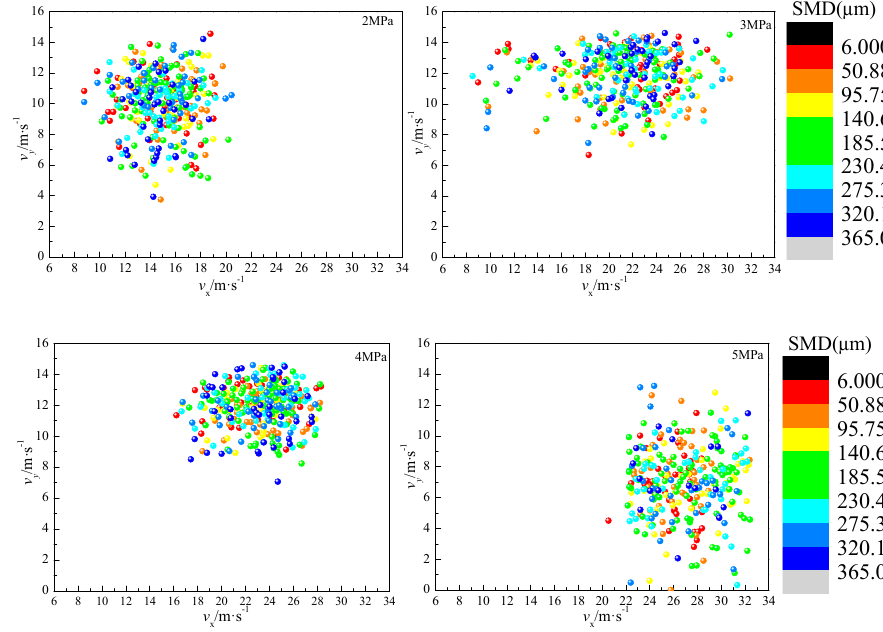
Figure 16. Joint particle size–velocity distribution changes with pressure (X = 50 mm, Y = 0 mm).